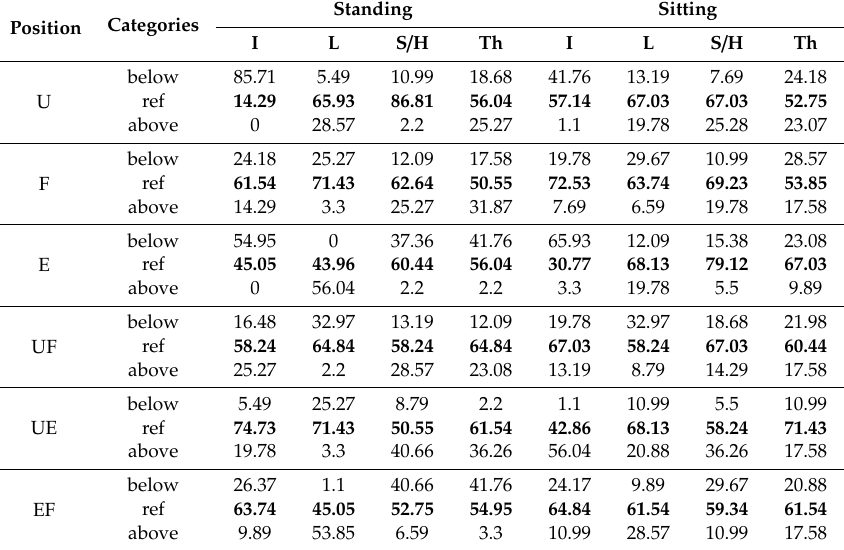
Bold indicates the ratio of the study population found in reference